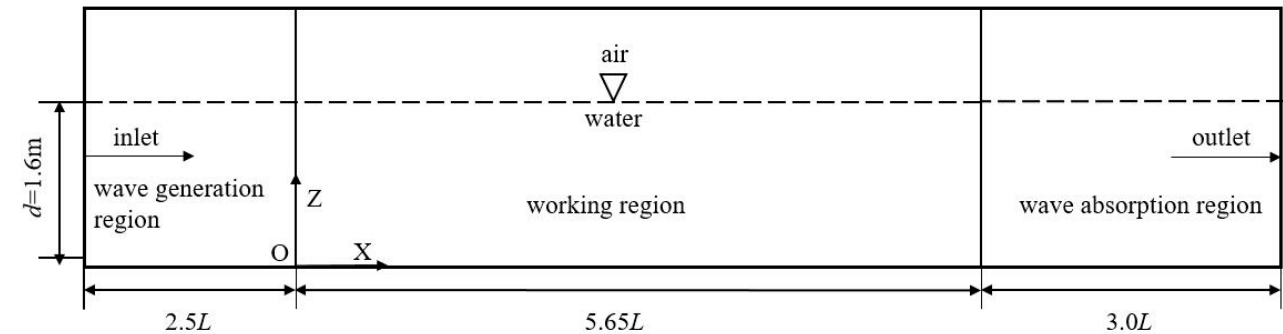
Figure 1. Sketch of numerical wave flume.